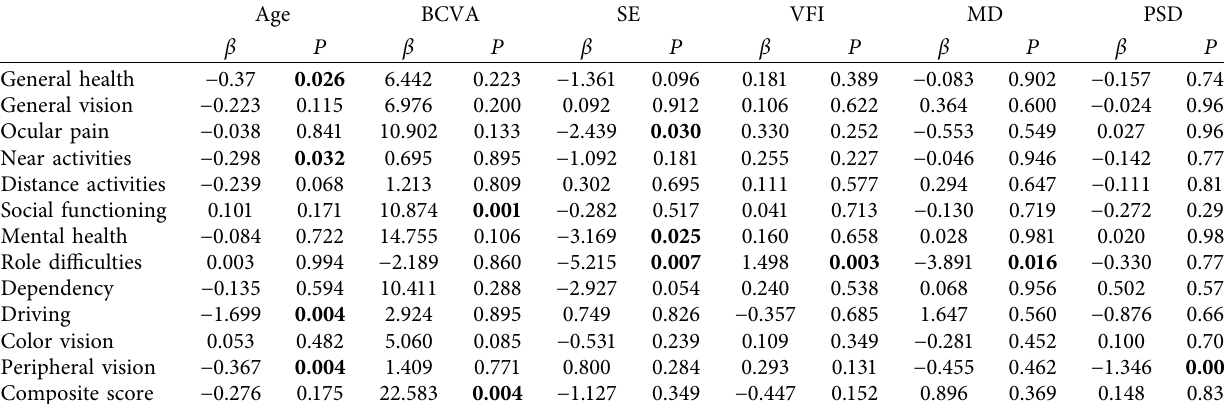
Table 2: Correlation coefcients of the association between visual function indexes and NEI-VFQ-25 of total participants. Age BCVA SE VFI